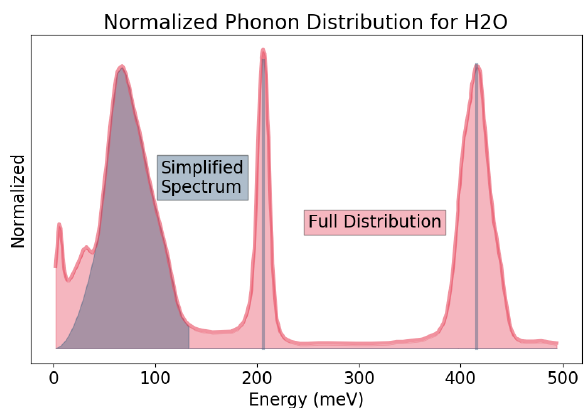
Figure 1: A full phonon distribution for water [2] is shown above in red, and a corresponding simplified distribution is shown in